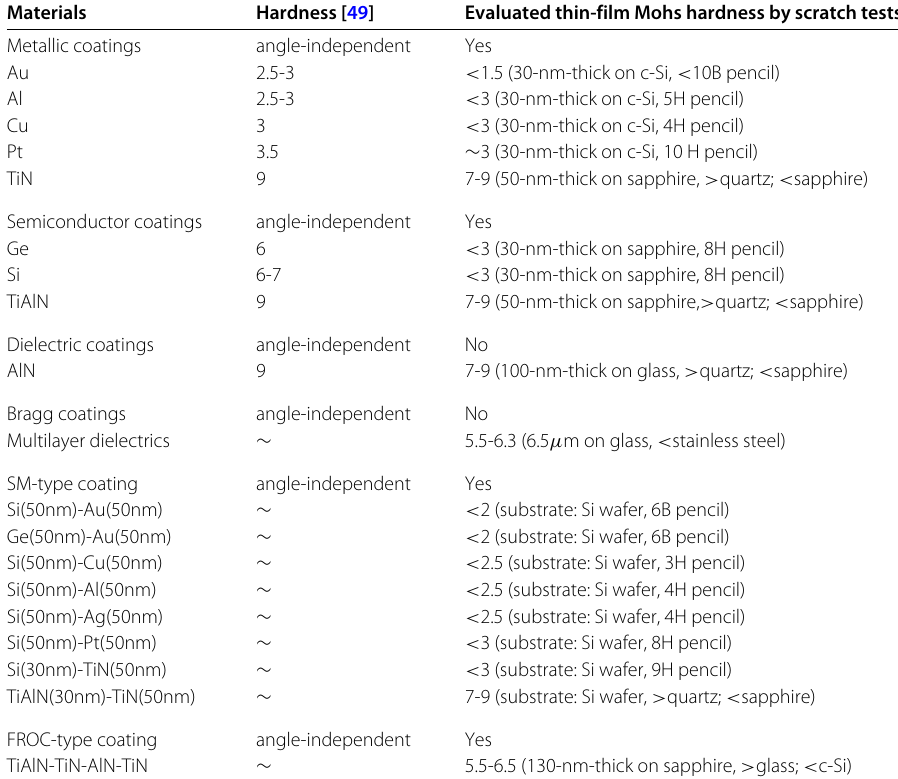
Table 1 Hardness of the common materials versus TiN, AlN and TiAlN for surface coloring. The Bragg coating is a commercially available mirror (EKSMA Optics, 042-5135) Materials Hardness [49] Evaluated thin-film Mohs hardness by scratch tests. Metallic coatings angle-independent